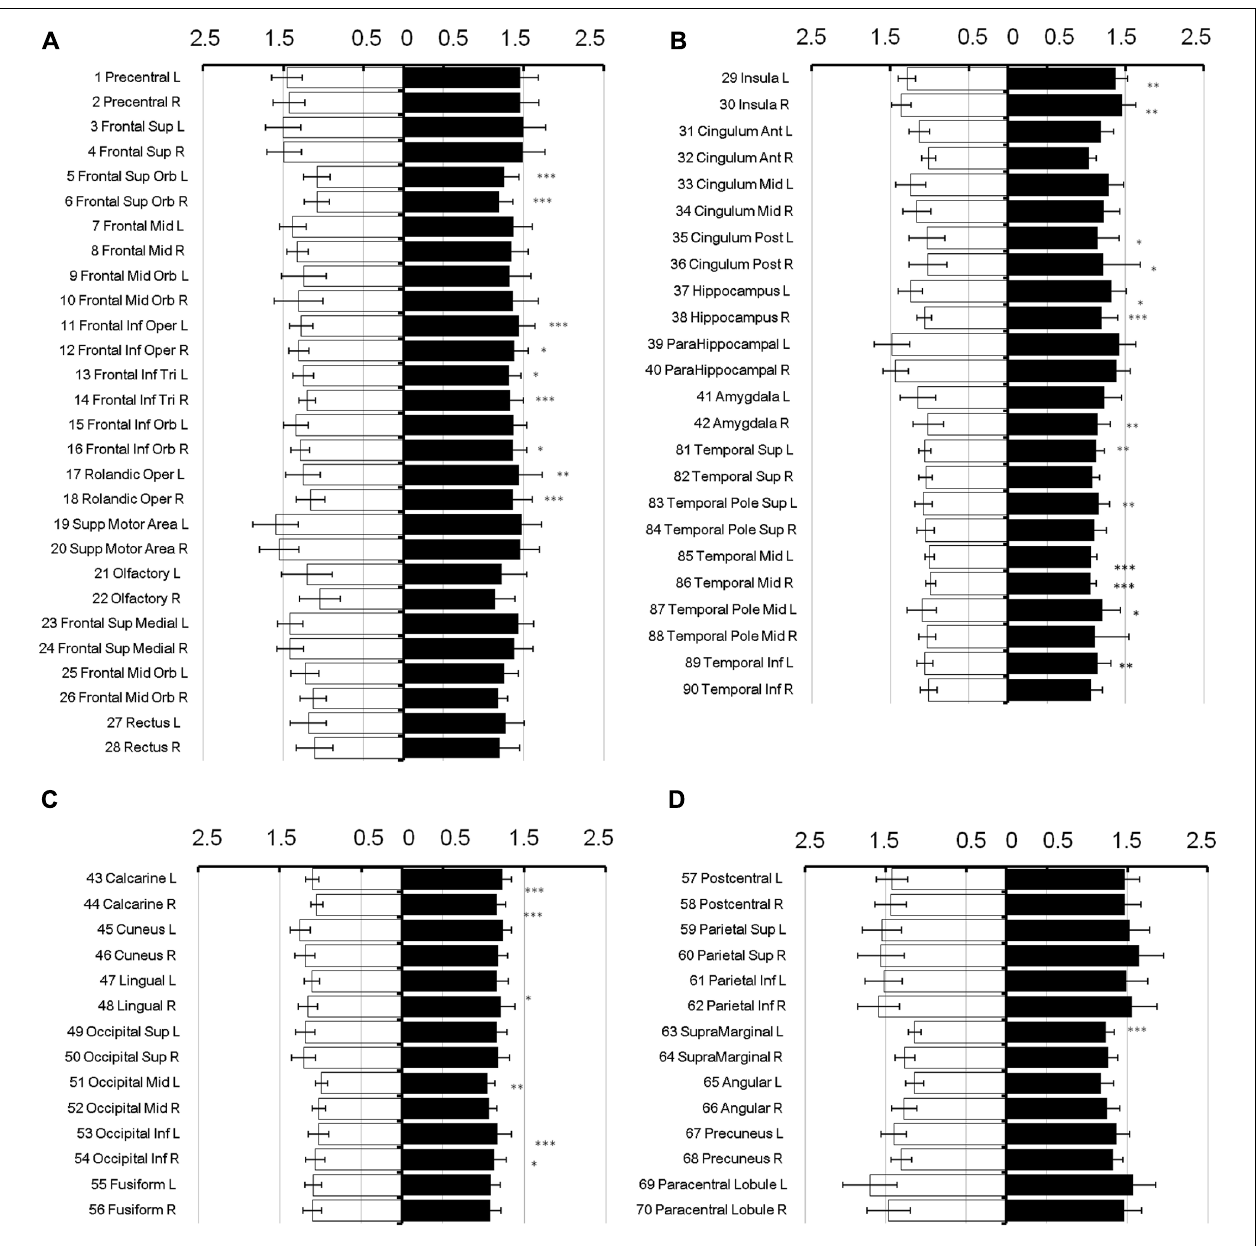
FIGURE 1 | Mean diffusivity in parcellated cortical regions. The mean diffusivity in the parcellated cortical regions was plotted for male [filled] and female [blank], respectively. The AAL regions were divided into frontal (A) , temporal and cingulum (B) , occipital (C) ,